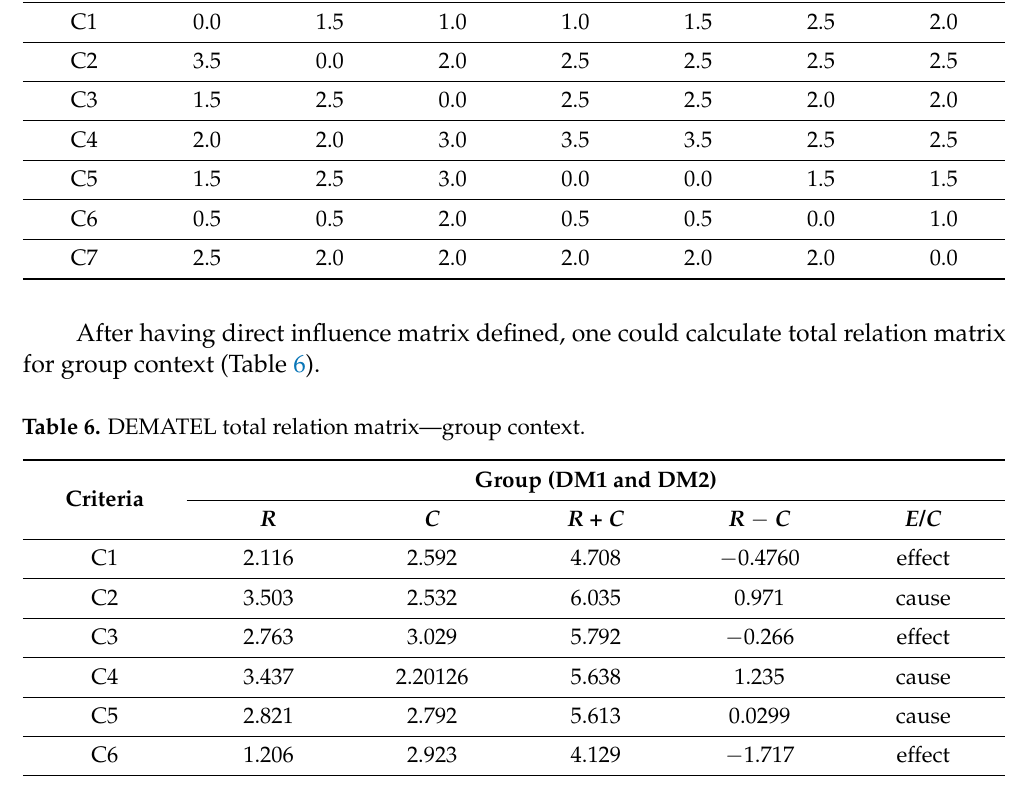
Table 5. DEMATEL direct influence matrix—group context.